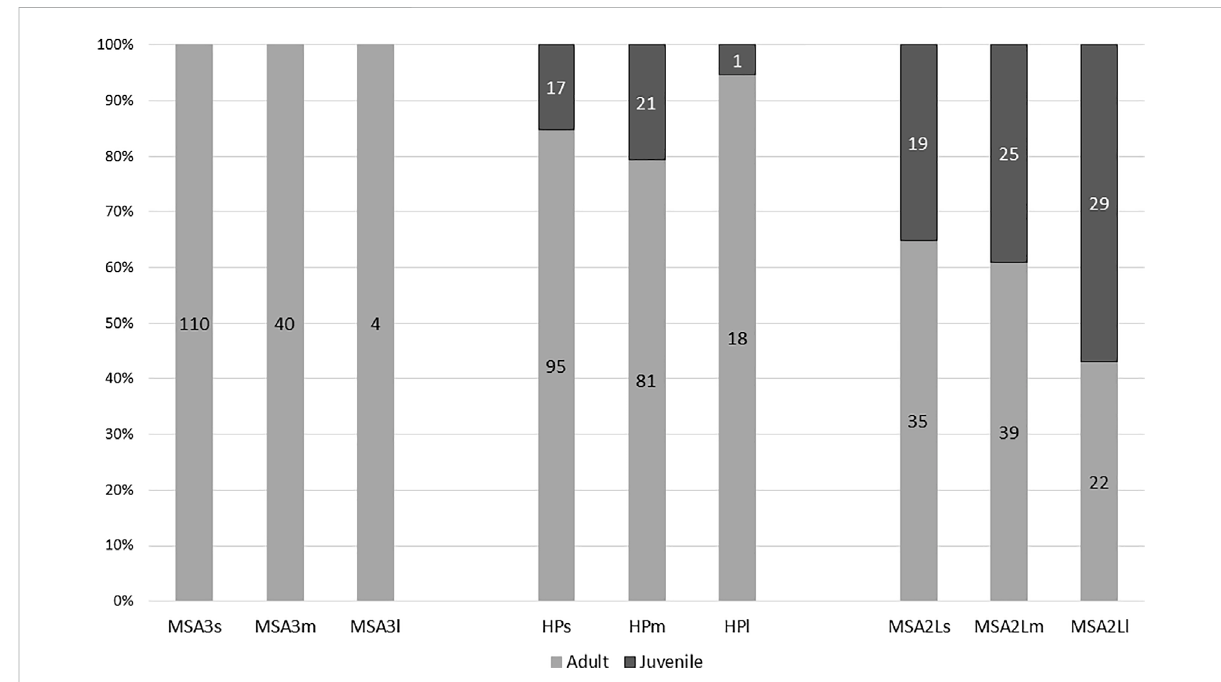
FIGURE 5 Mortality pro fi les for small (s), medium (m) and large mammals (l) at Klasies River. Number of specimens in